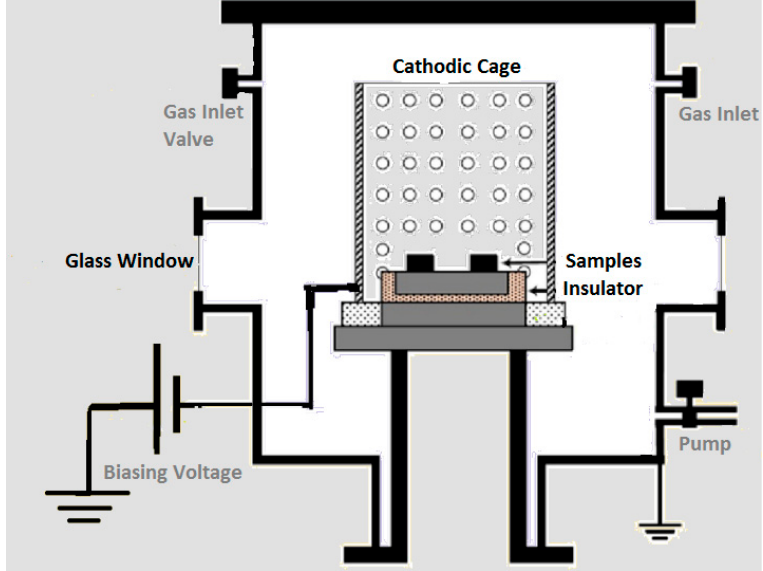
Figure 1. Schematic of CCPN treatment system.